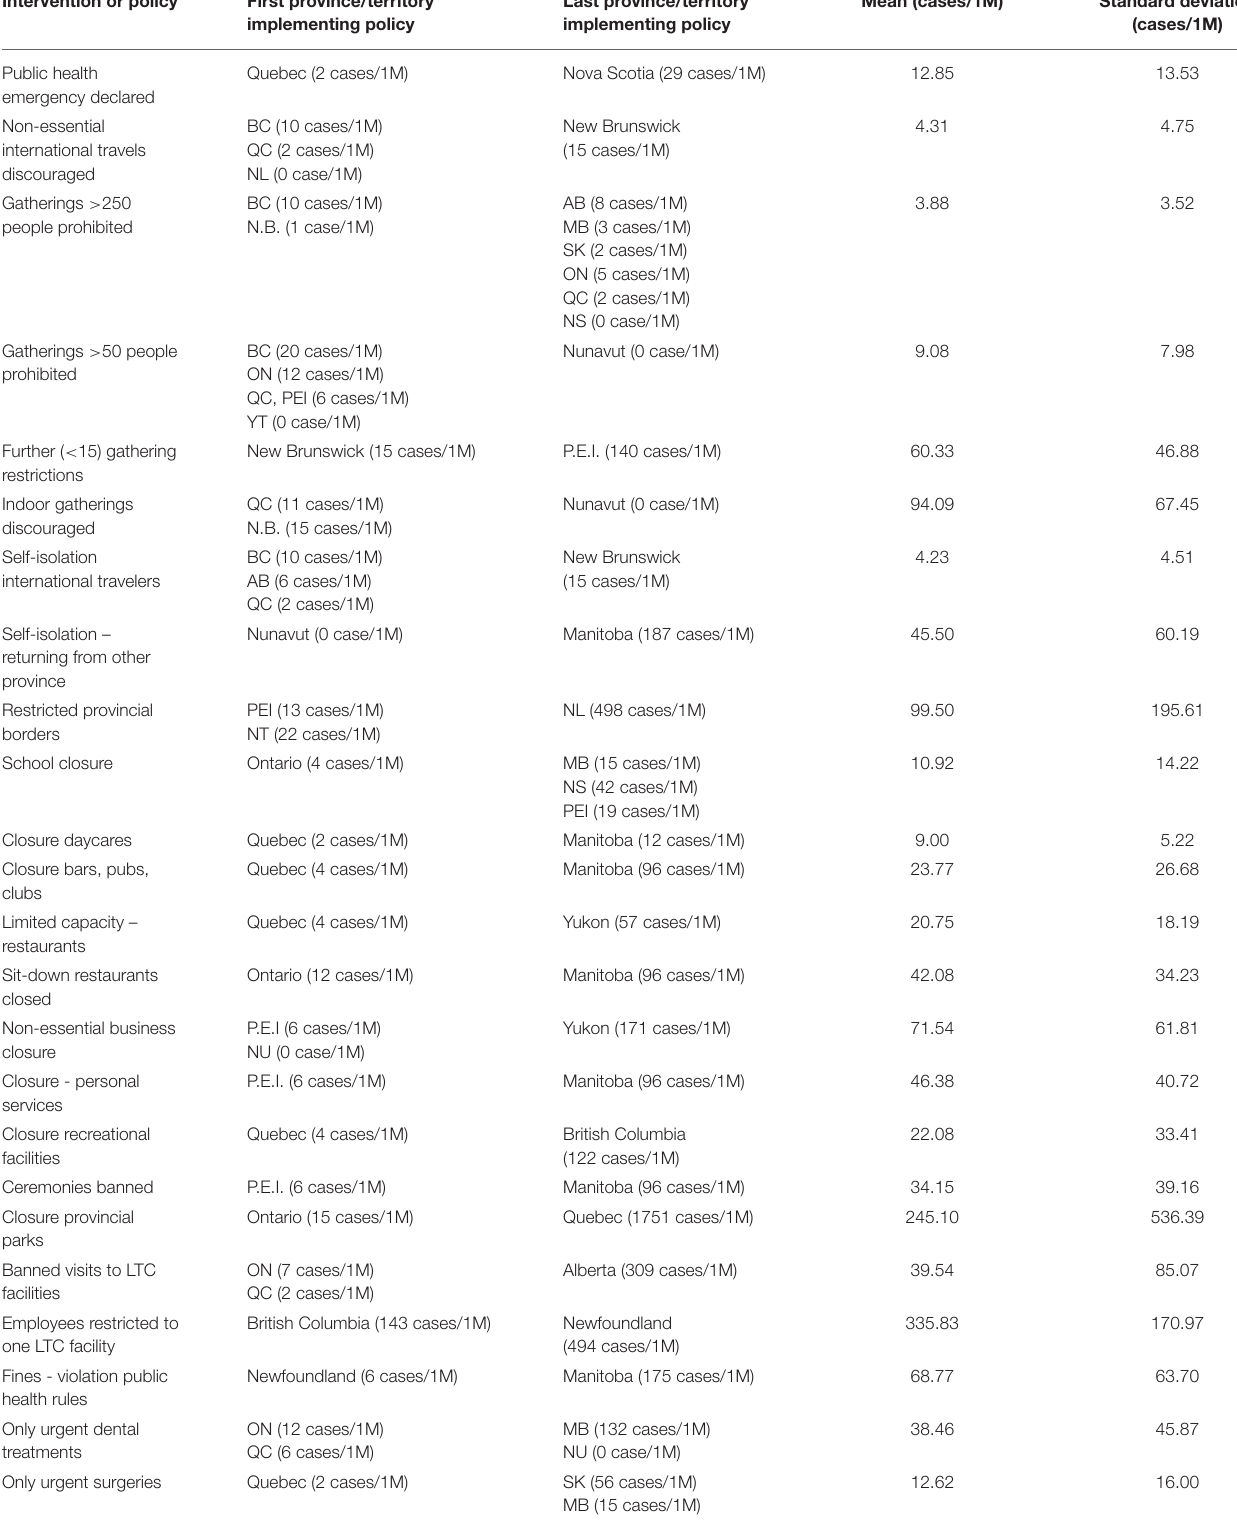
TABLE 2 | Public health interventions during the early COVID-19 pandemic analyzed by cases per province or territory at the time of implementation. Intervention or